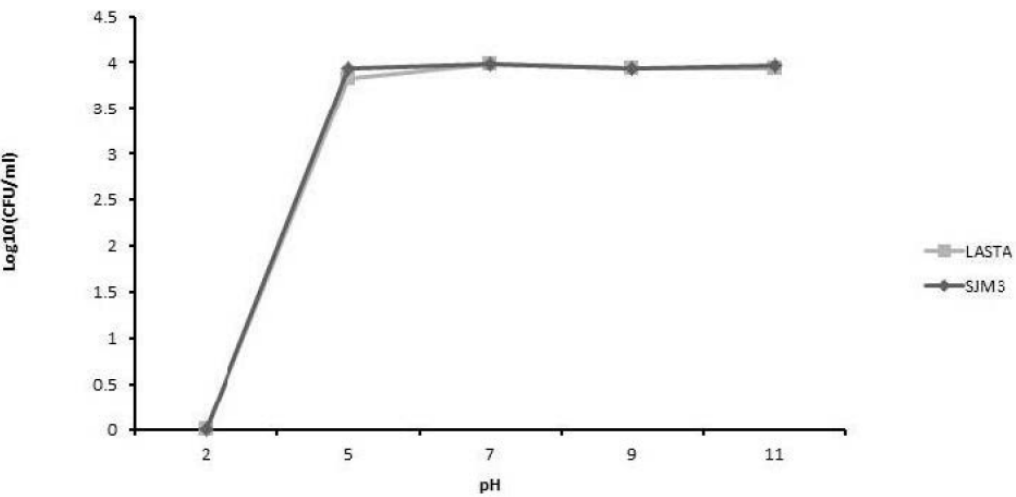
Figure 7. The effect of pH on phage stability. LASTA and SJM3 are inactivated in the extreme acidic environment of pH 2, while they are stable in the range of pH 5 to pH 11.